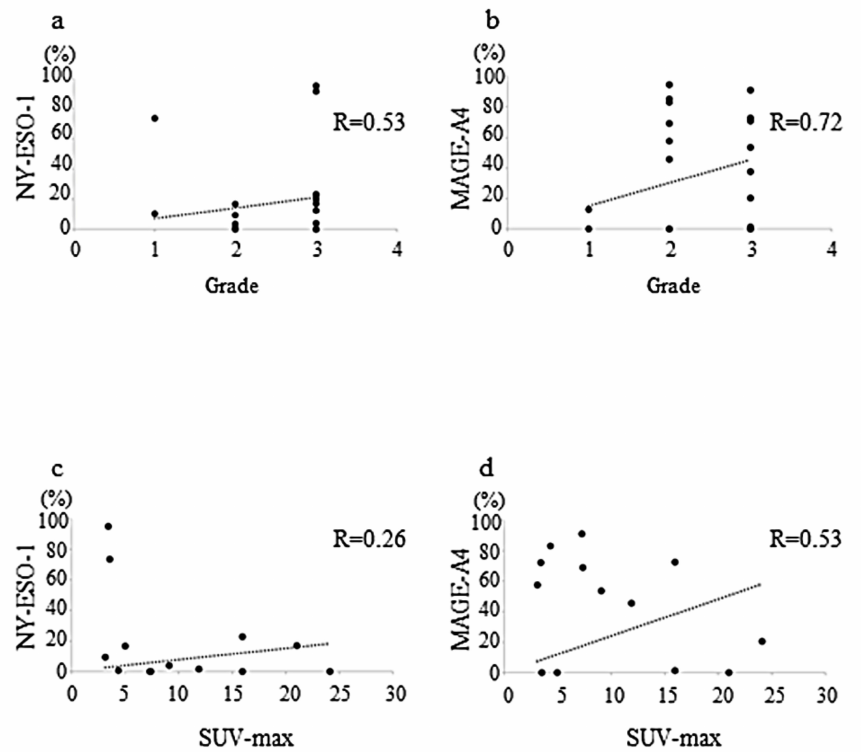
Figure 4. Graphs showing a weakly positive correlation between histological grade and NY-ESO-1 expression (r = 0.53) in sarcomas ( a ); very strong positive correlation between the histological grade and MAGE-A4 expression (r = 0.72) in sarcomas ( b ); no correlation was observed between the maximum standardized uptake value (SUVmax) and NY-ESO-1 expression (r = 0.26) in sarcomas ( c ); weak positive correlation between the SUVmax and MAGE-A4 expression (r = 0.53) in sarcomas ( d